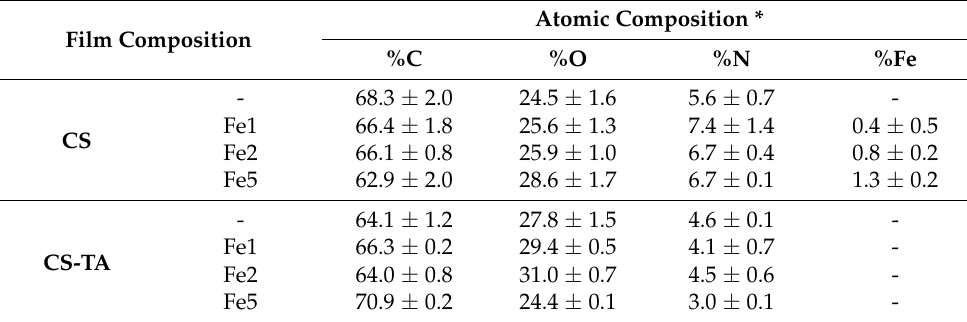
Table 3. Surface atomic composition assessed by XPS survey